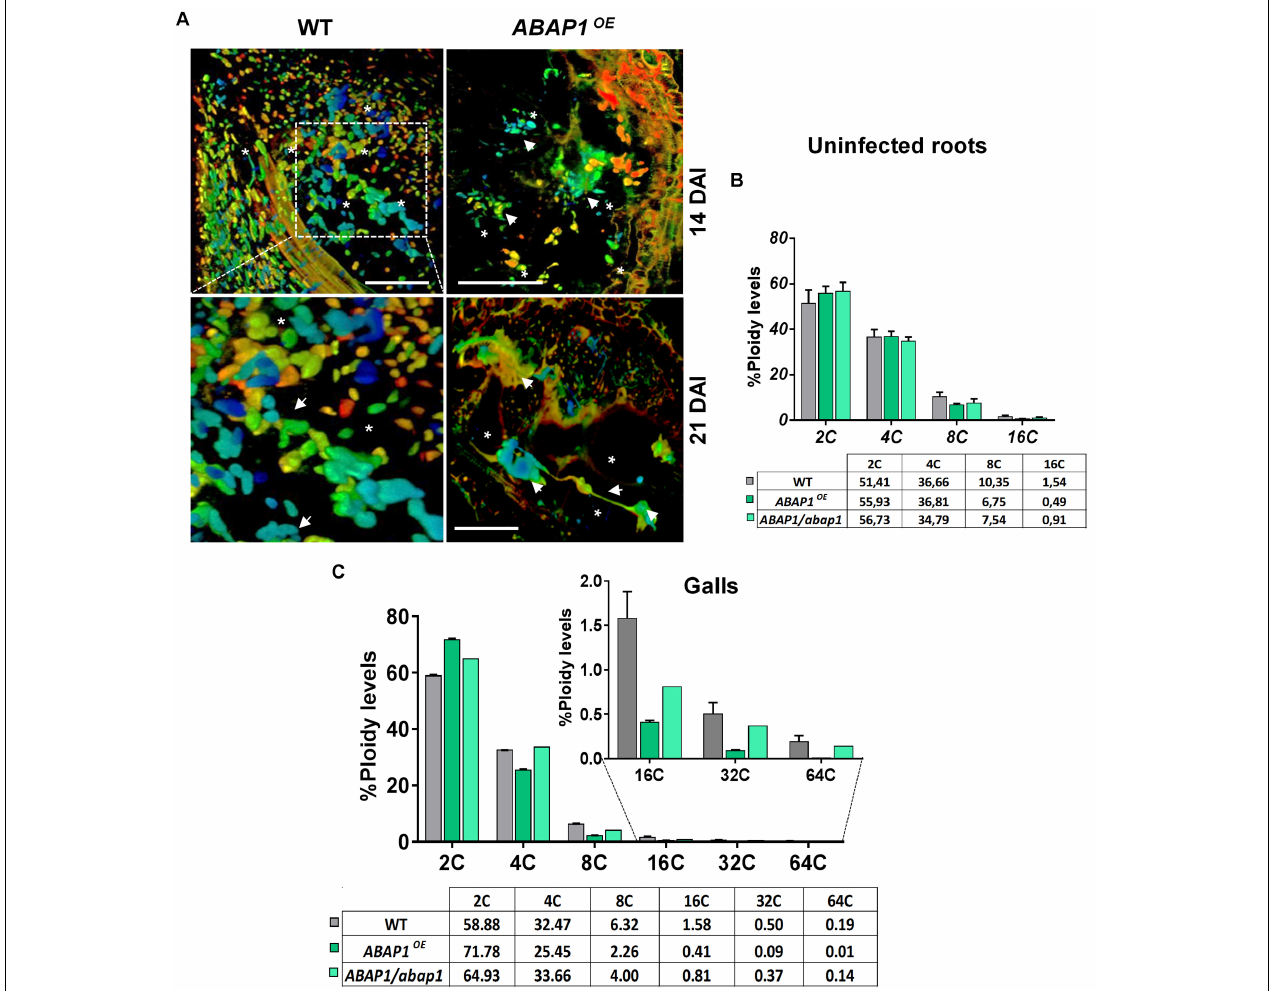
FIGURE 7 | ABAP1 overexpression affects nuclei morphology and ploidy levels in M. incognita-induced galls. (A) 3D confocal projections of serial optical sections of wild-type (WT) and ABAP1 OE galls 14 and 21 DAI nuclei (white arrows), cleared and stained with 4,6-diamidino-2-phenylindole (DAPI). Elongated and apparently connected nuclei are observed in giant cells in ABAP1 OE galls 21 DAI. DAI, days after inoculation; asterisk, giant cell. Bars = 50 µ m. (B,C) Flow cytometry analysis and ploidy levels (percentage) of uninfected roots (B) , and galls of ABAP1 OE and ABAP1/abap1 lines compared to WT (C) . The ploidy levels were kept high for GCs in ABAP1/abap1 as in WT and decreased progressively from 8C to 64C in ABAP1 OE , when compared to ABAP1/abap1 and WT galls. For each line and experiment, three independent biological repetitions ( ± 30 galls) were performed. Scale bars = 50 µ